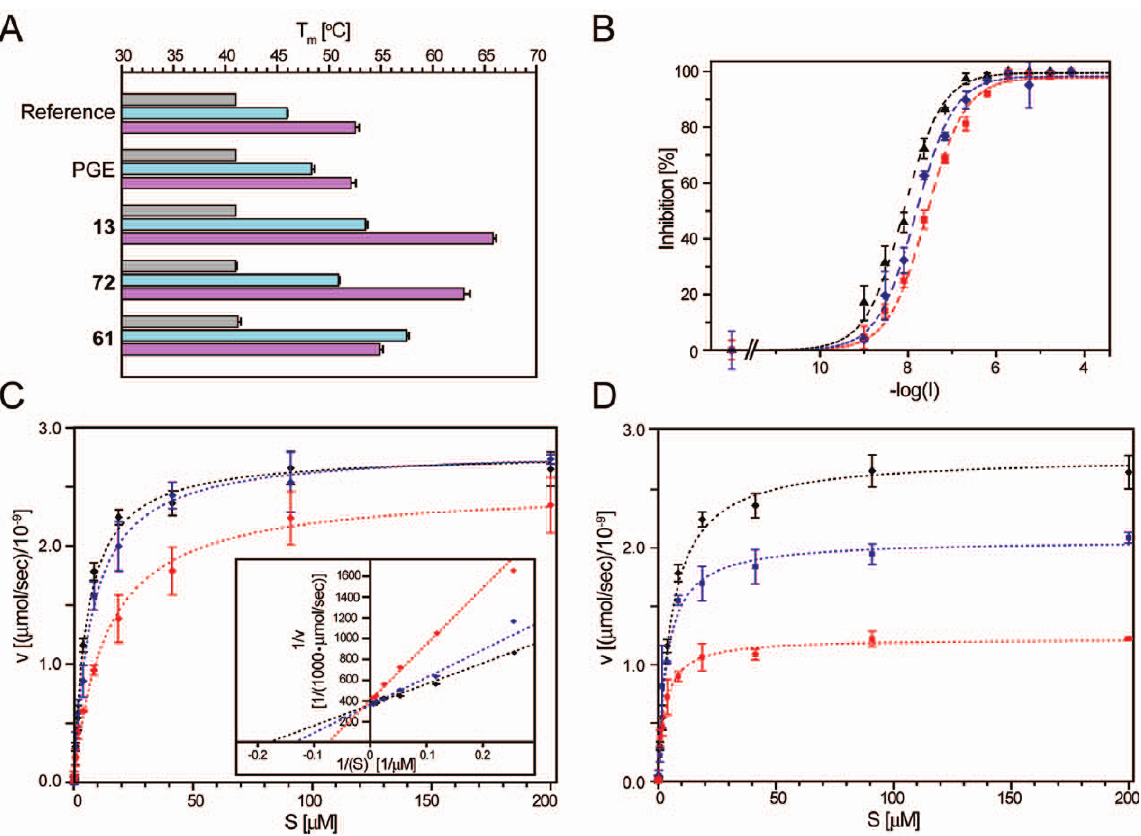
Figure 4. Effects of the re-synthesized compounds on stability and activity of human 15-PGDH. A. Thermal stability of the protein in dependence of substrate and inhibitors, without cofactor (grey bars), and in presence of NAD + (light blue bars) as well as in presence of NADH (purple bars). Shown are sets of these data, respectively, for each of the tested compounds as denoted on the Y axis. Bars represent averages of three independent experiments, with standard deviations displayed as error bars. B. Inhibitor dose-dependent reduction of the enzyme activity caused by compounds 13 (black triangles), 72 (blue squares) and 61 (red diamonds), respectively. Plotted values are means of three independent experiments, with standard deviations displayed as vertical error bars. Dashed or dotted lines, in colors corresponding to the data points, result from least-squares non-linear fitting of the data to the Hill equation (see Materials & Methods), respectively. C & D. Michaelis-Menten plots of the enzyme activity at varying concentrations of substrate, PGE 2 , in absence of inhibitor (black symbols) or in presence of compounds 61 ( C ) or 13 ( D ) at concentrations close to (blue symbols) or above (red symbols) their IC 50 values, specified in table 3. The inset graph in D shows the data from the main graph as Lineweaver-Burk plot, demonstrating competitive inhibition from independence of the Y-axis intercept (1/ V max ) of the inhibitor concentration. All values are means of three independent measurements; standard deviations are displayed as vertical error bars.